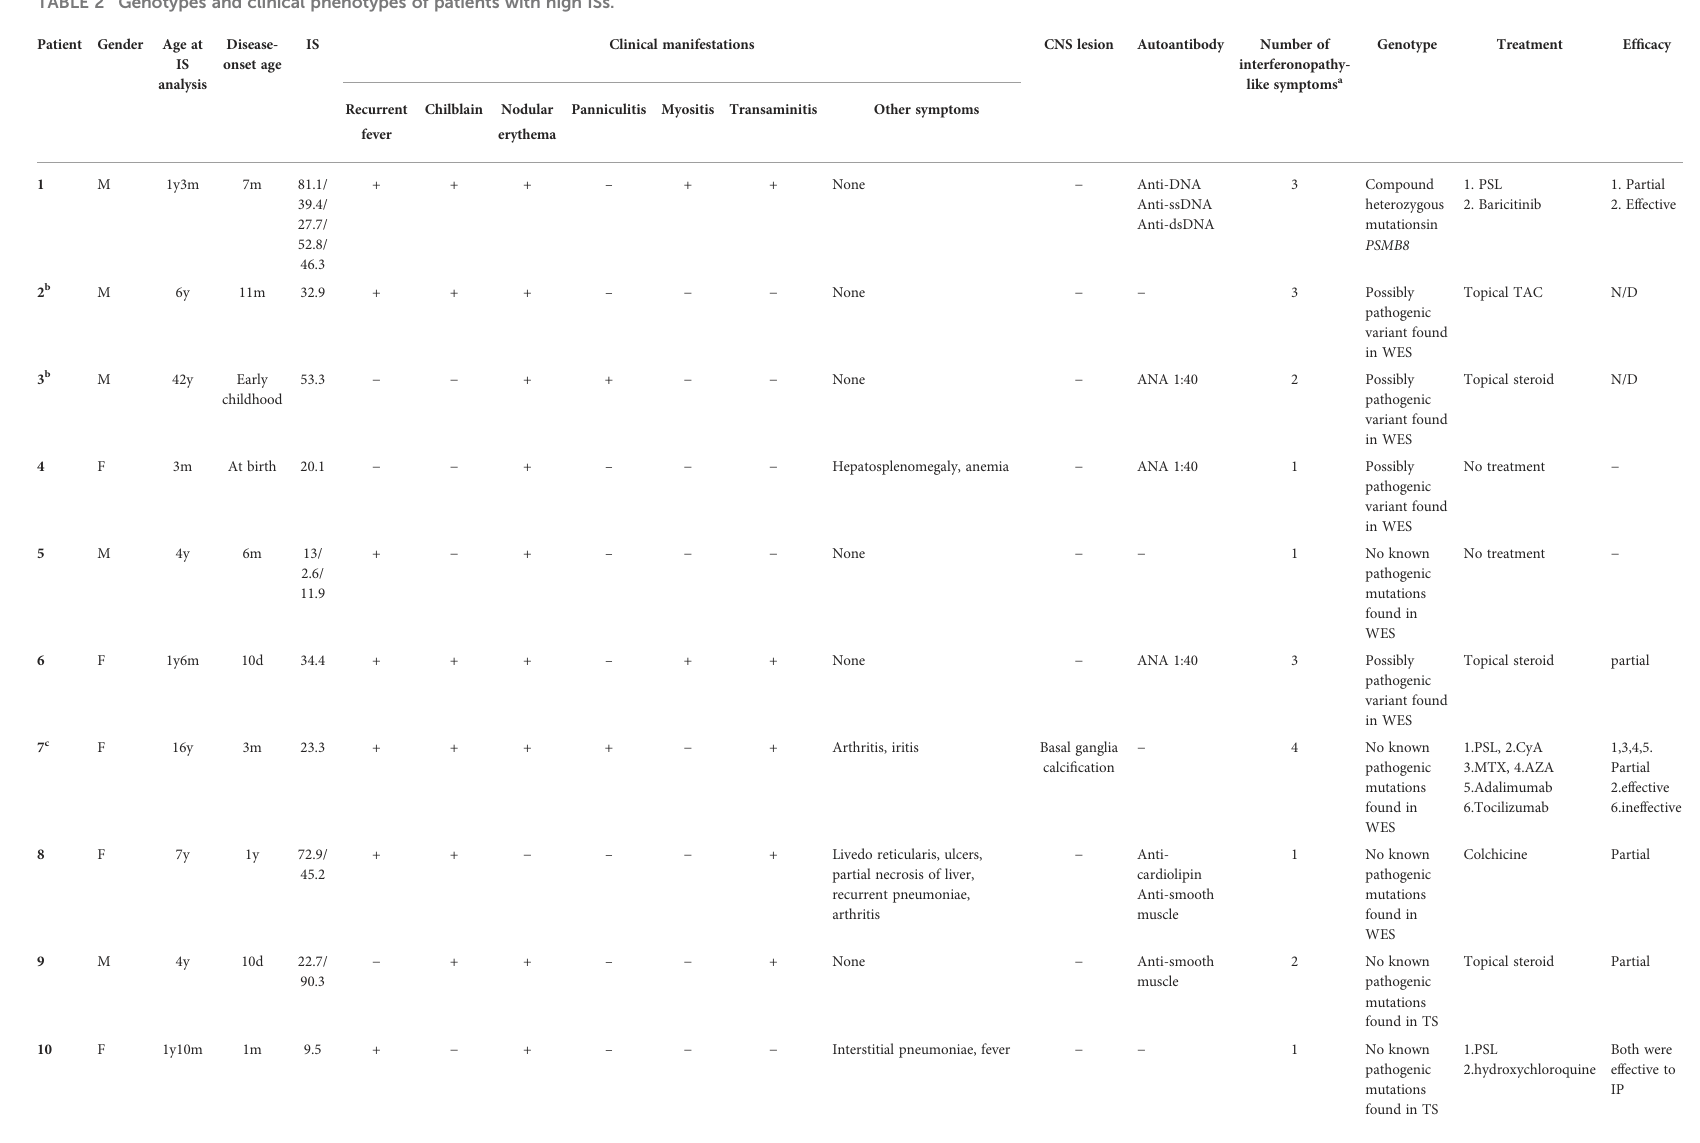
TABLE 2 Genotypes and clinical phenotypes of patients with high ISs. Patient Gender Age at IS